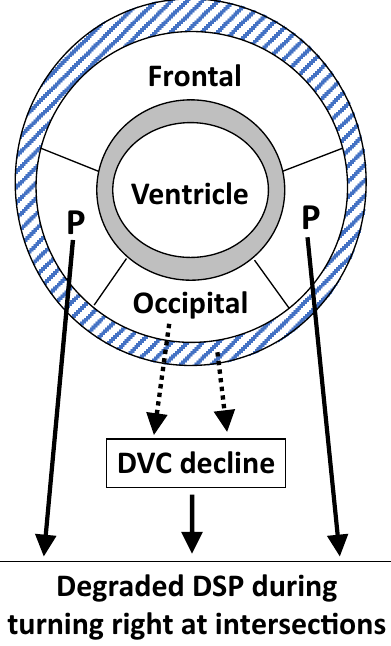
Figure 4. Leukoaraiosis (LA) in the parietal and occipital lobes and brain atrophy (BA) were significantly correlated with driving safety performance (DSP) and dynamic visual cognition (DVC). P, parietal lobe; Shaded zone, BA; Grey zone, periventricular LA; dashed lines, significant correlations with DVC; solid lines, significant correlations with